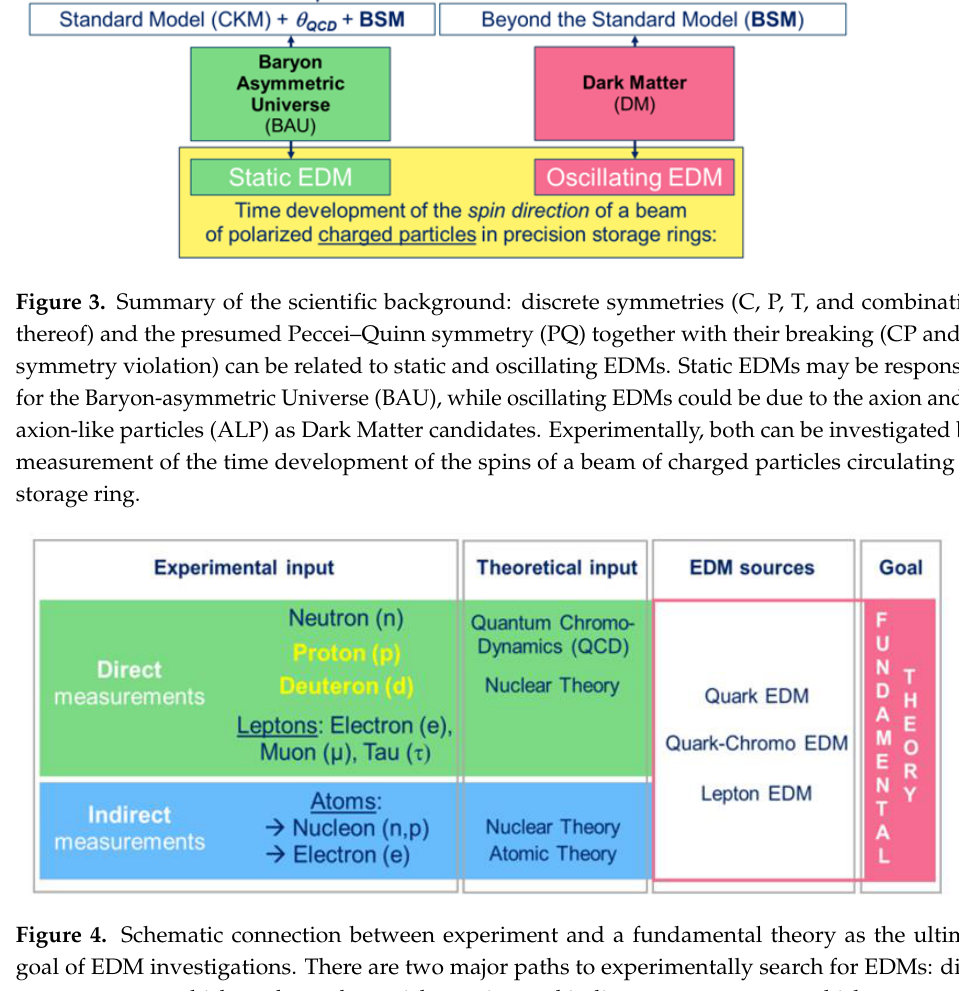
Figure 3. Summary of the scientific background: discrete symmetries (C, P, T, and combinations thereof) and the presumed Peccei – Quinn symmetry (PQ) together with their breaking (CP and PQ symmetry violation) can be related to static and oscillating EDMs. Static EDMs may be responsible for the Baryon-asymmetric Universe (BAU), while oscillating EDMs could be due to the axion and/or axion-like particles (ALP) as Dark Matter candidates. Experimentally, both can be investi- gated by a measurement of the time development of the spins of a beam of charged particles circu- lating in a storage ring.